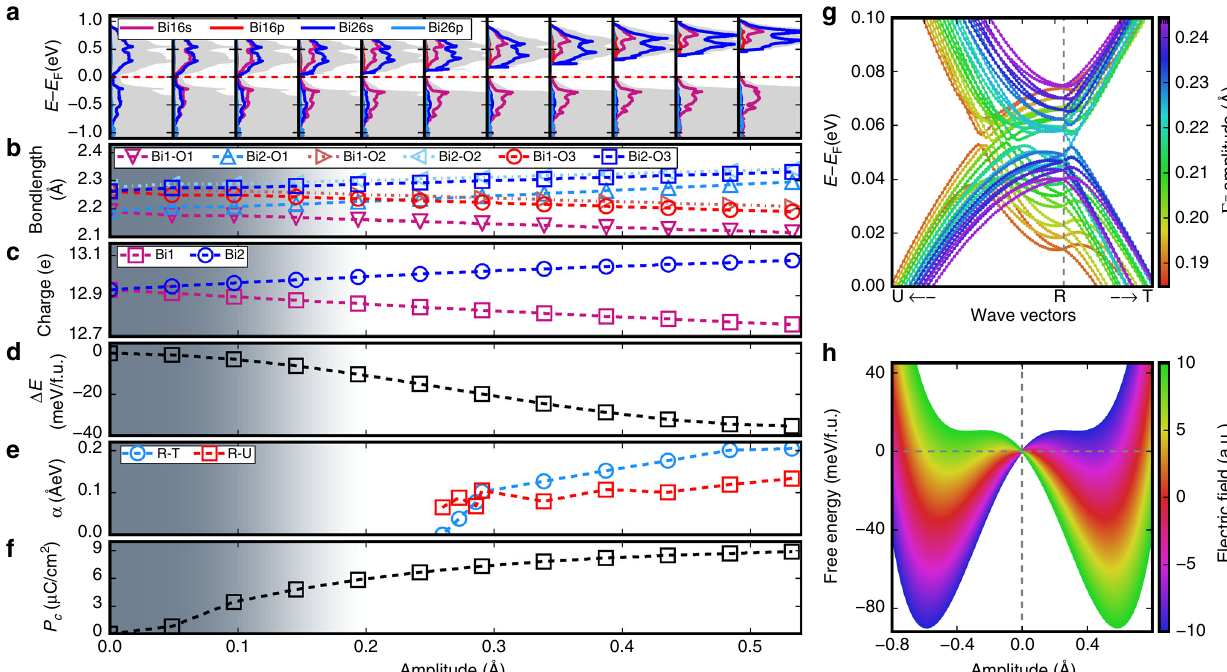
) amplitude. a Projected density of states (the Fig. 3 The evolution of crystal structure and electronic properties of Ag 2 BiO 3 as a function of polar mode ( Γ (cid:3) 2 gray shading represents the total density of states), b Bi – O bond lengths, c Bader charges of Bi atoms (note that since the description of charge states in solid is ambiguous, the charge calculated using Bader ’ s method should not be used for quantitative comparison with the formal charge (Bi 3+ and Bi 5+ )), d energy difference ( Δ E ) between paraelectric phase ( Pnna ) and ferroelectric phase ( Pnn 2), e Rashba – Dresselhaus parameters α along R – U and R – T directions, f spontaneous ferroelectric polarization ( P z ), and g band structure along the U – R – T direction. The gray-white gradient background represent the transition from the metallic (gray) and insulating (white) phases. h Free energy of ferroelectric Ag 2 BiO 3 ( Pnn 2) as a function of the external electric fi eld ( | E | ) and polar distortion ( Q Γ (cid:3) ). The free energy density G in the Landau – Ginzburg polynomial expansion with the amplitude of polar distortion Q Γ (cid:3) is: 2 2 G ¼